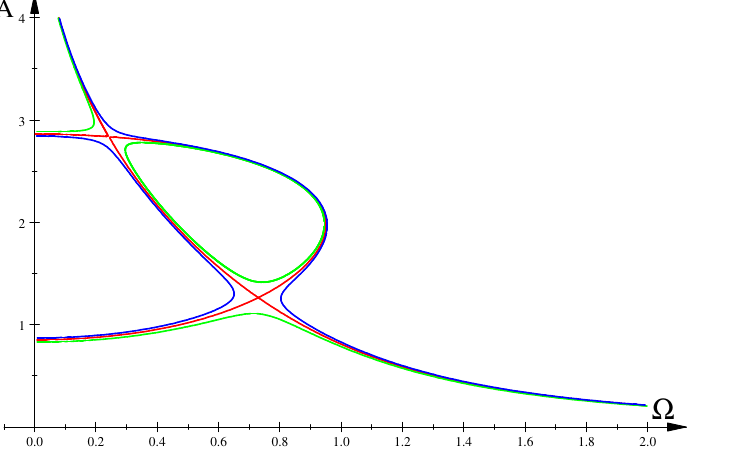
Figure 7. Amplitude profile with two intersections, ( µ 0 , ν 0 , G 0 ) = ( 1.1, 0.797754, 0.777016 ) . Lef top and right top figures show the disruption of the bifurcation curve due to metamorphosis at the left self-intersection in Figure 7 while the left bottom and right bottom curves show, for an inverted time flow, analogous bifurcation due to metamorphosis at the right self-intersection in Figure 7. Green and blue colours in Figure 8 correspond to green and blue colours in Figure